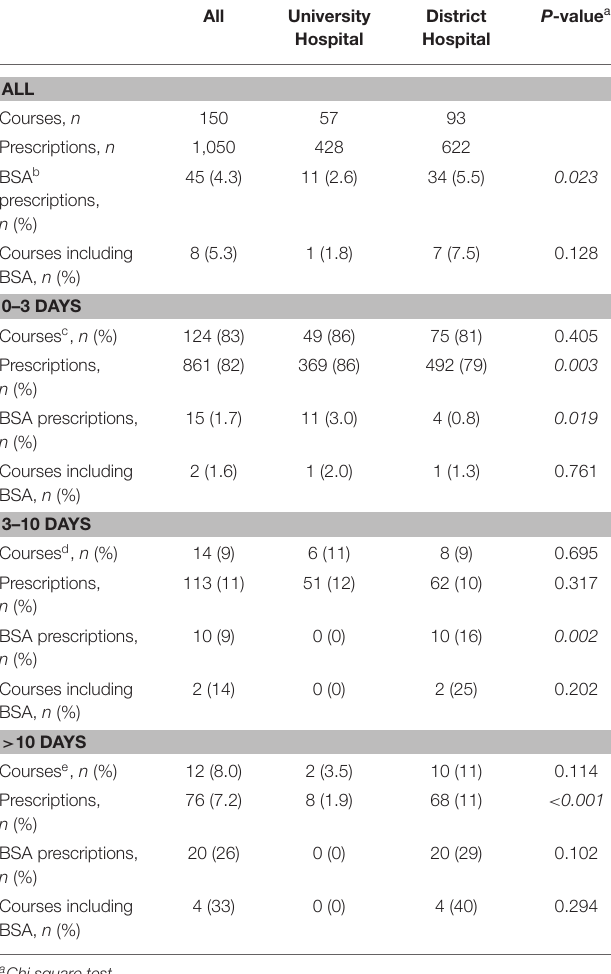
TABLE 2 | Distribution of antibiotic exposure in two Norwegian neonatal units (GA > 28) based on start of antibiotic exposure, 2017.